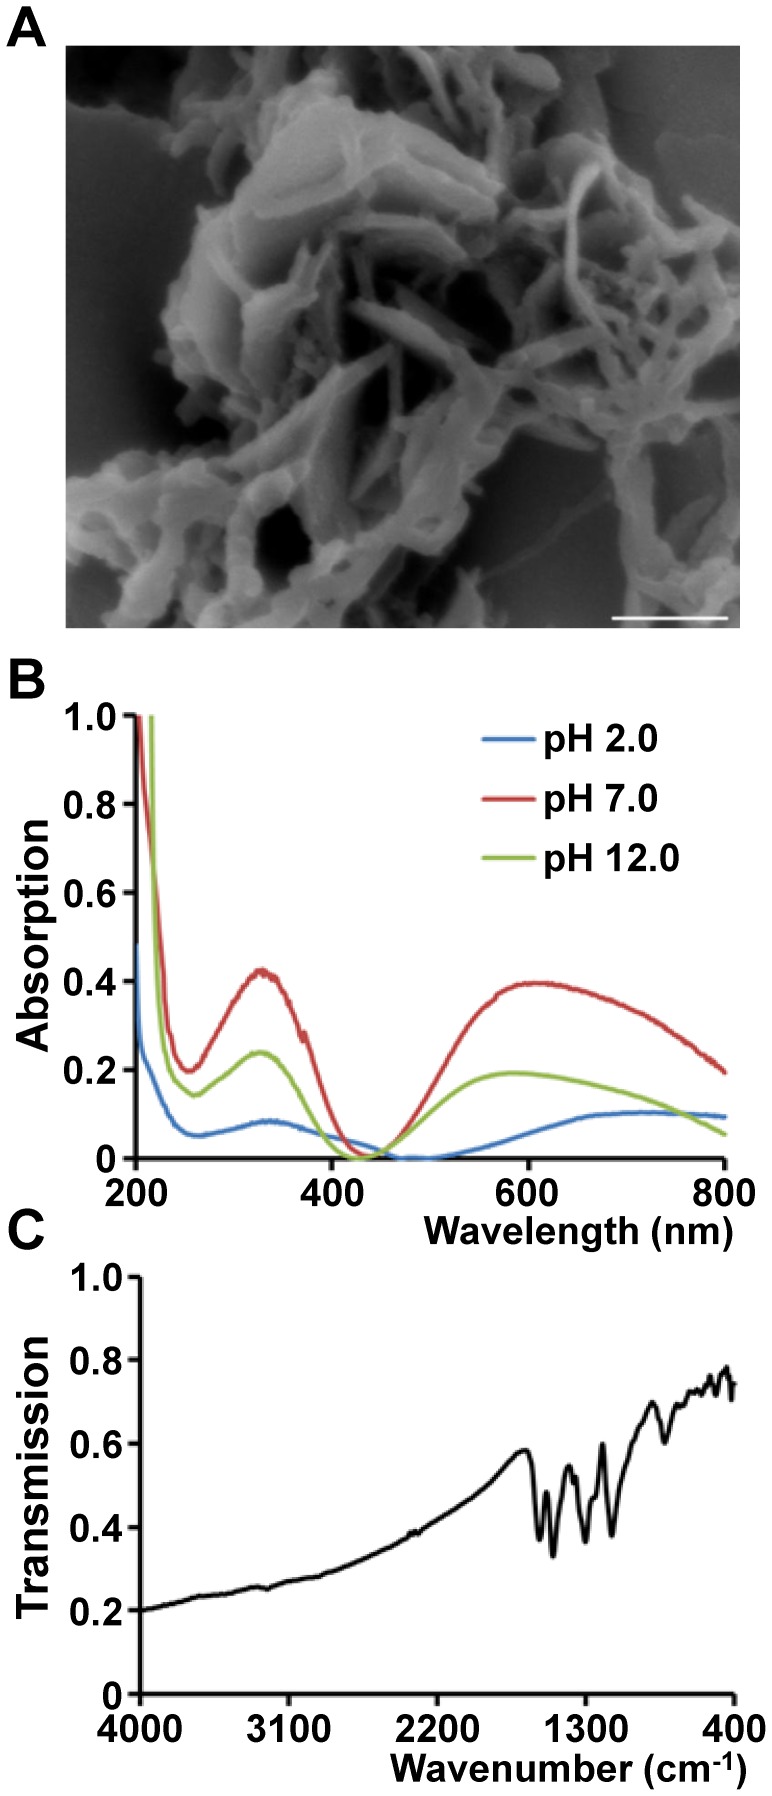
Characterization of nPANI.(A) The scanning electron microscope image of nPANI. Scale bar is 500 nm. (B) UV-vis absorption spectra of nPANI aqueous solutions at pH 2.0, pH 7.0, and pH 12.0. Ultra DI-water was used as a background solution. (C) FTIR spectrum of nPANI. KBr was used as a background.